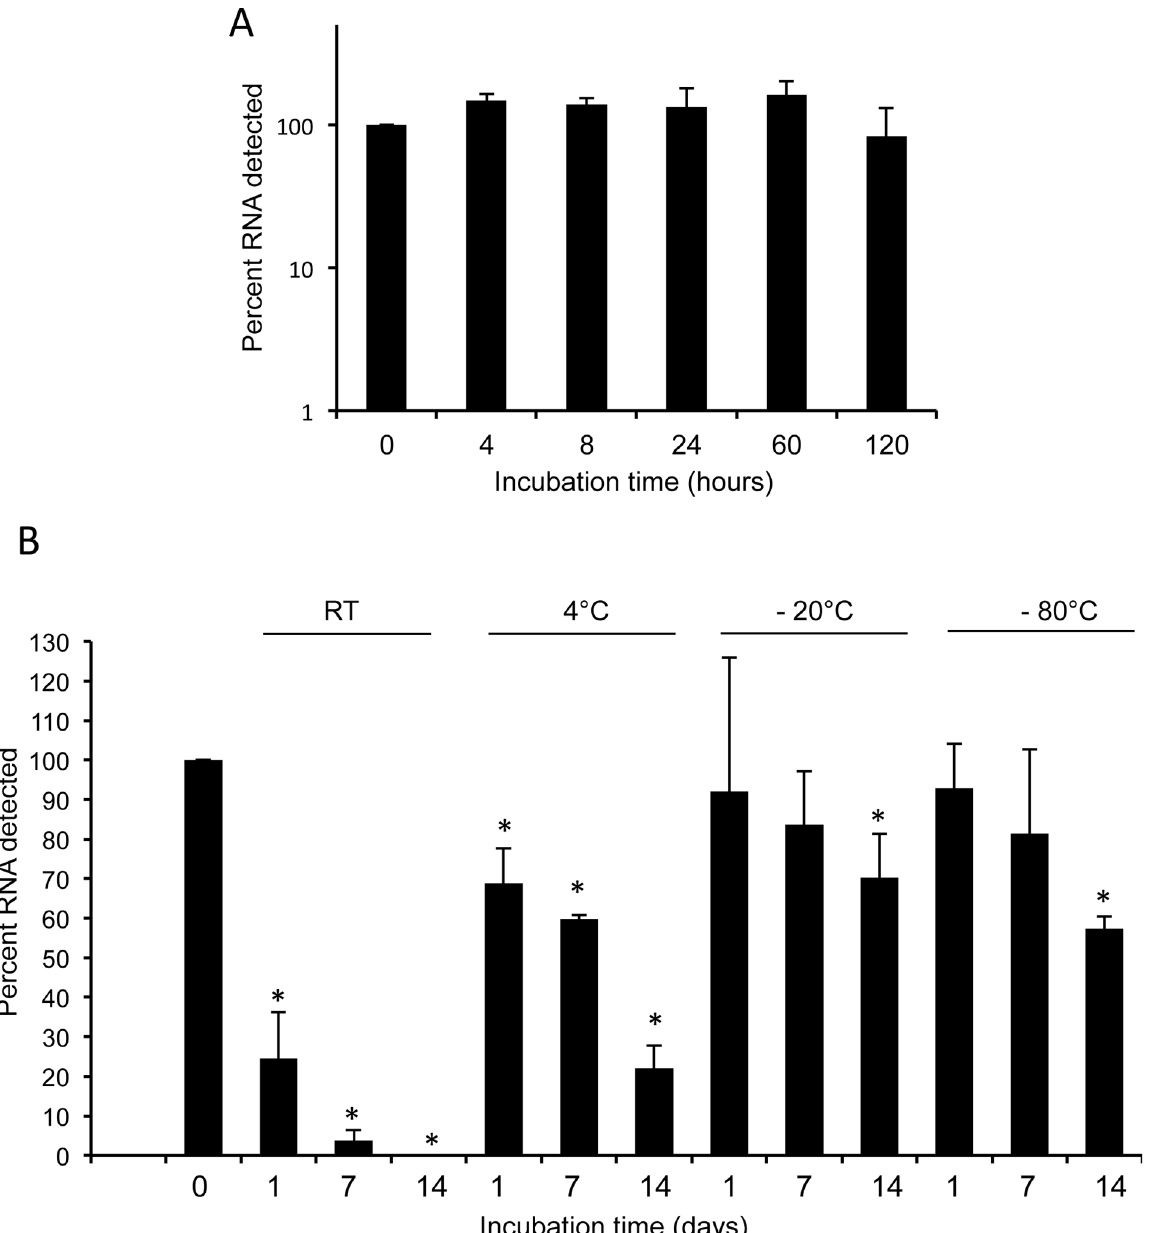
Fig 4. Stability of Leptospira 16S transcripts in human blood. A) Transcript stability in the blood treated with an RNA stabilization agent. Aliquots of human blood were spiked with leptospires (100 cells/ml), mixed with an RNase stabilization agent (TRIzol), and each aliquot was stored at room temperature for various times (0 – 120 hours). Following storage, levels of 16S rRNA transcripts were measured using qRT-PCR assays. Data represent results from three independent experiments. B) Transcript stability in the blood stored at various temperatures in the absence of any RNA stabilization agent. Spiked samples were prepared as described above and stored either at room temperature or at various cold temperatures (4°C, -20°C, and -80°C) up to 14 days, and transcript levels were monitored by qRT-PCR analyses. Transcript levels of “ 0 hour ” were considered as 100%, which served as baseline controls, which displayed significant differences in transcript levels in groups marked by an asterisk (ANOVA, p < 0.05). Data represent results from three independent